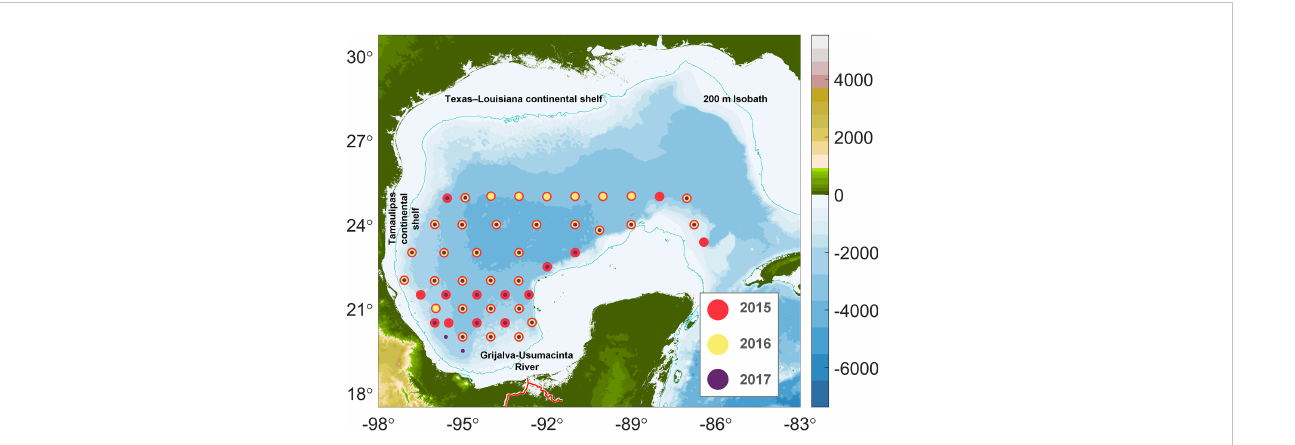
FIGURE 1 Sampling stations covered in the 2015, 2016, and 2017 XIXIMI cruises. Red circles represent stations sampled during 2015, yellow circles stations sampled in 2016 and purple circles the stations sampled in 2017. The blue line represents the 200m isobath, and the red line the Grijalva- Usumacinta River